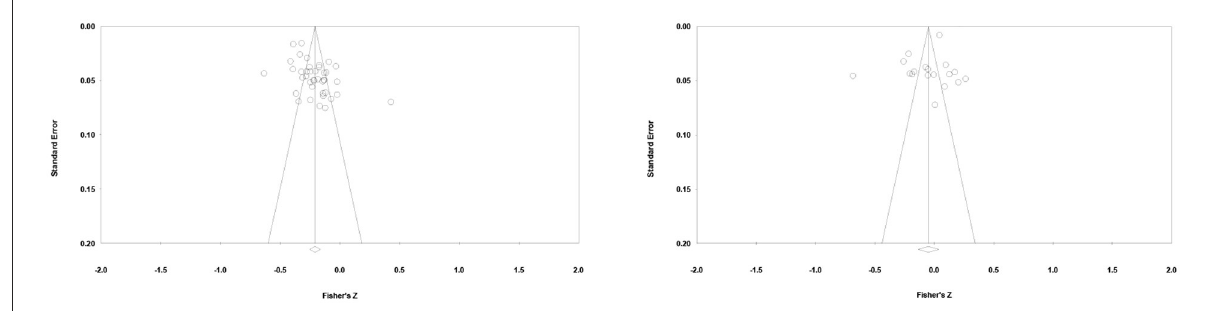
FIGURE2 Funnel plots; materialistic values (left), extrinsic aspirations (right).